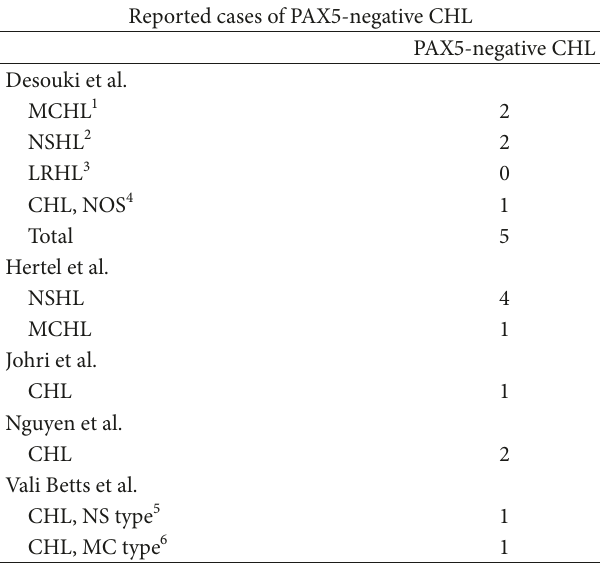
Table 1: PAX5-negative HRS cells in different variants of